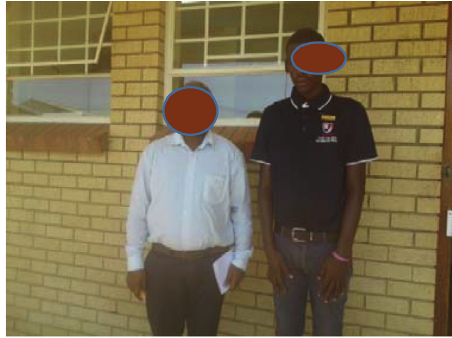
Figure 13: TVET final-year student: site